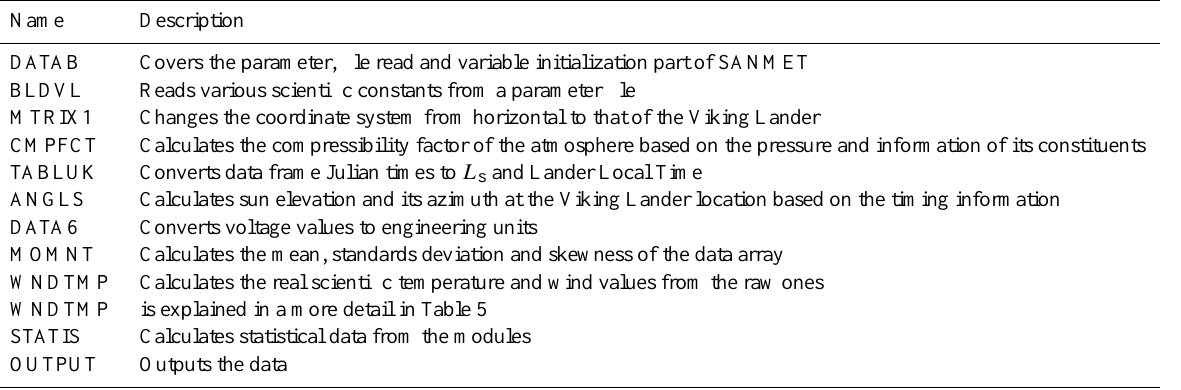
Table 4. Supporting scientific variable calculation (SANMET